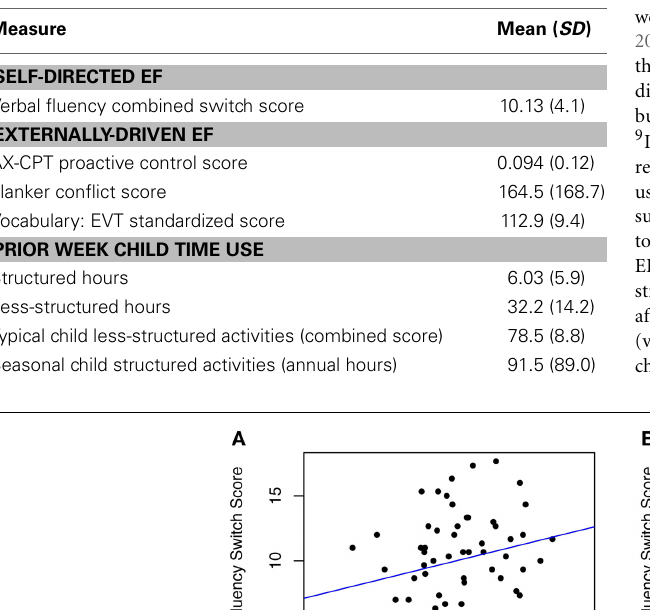
Table 2 | Descriptive statistics for executive function, vocabulary, and time use measures ( N ’s =